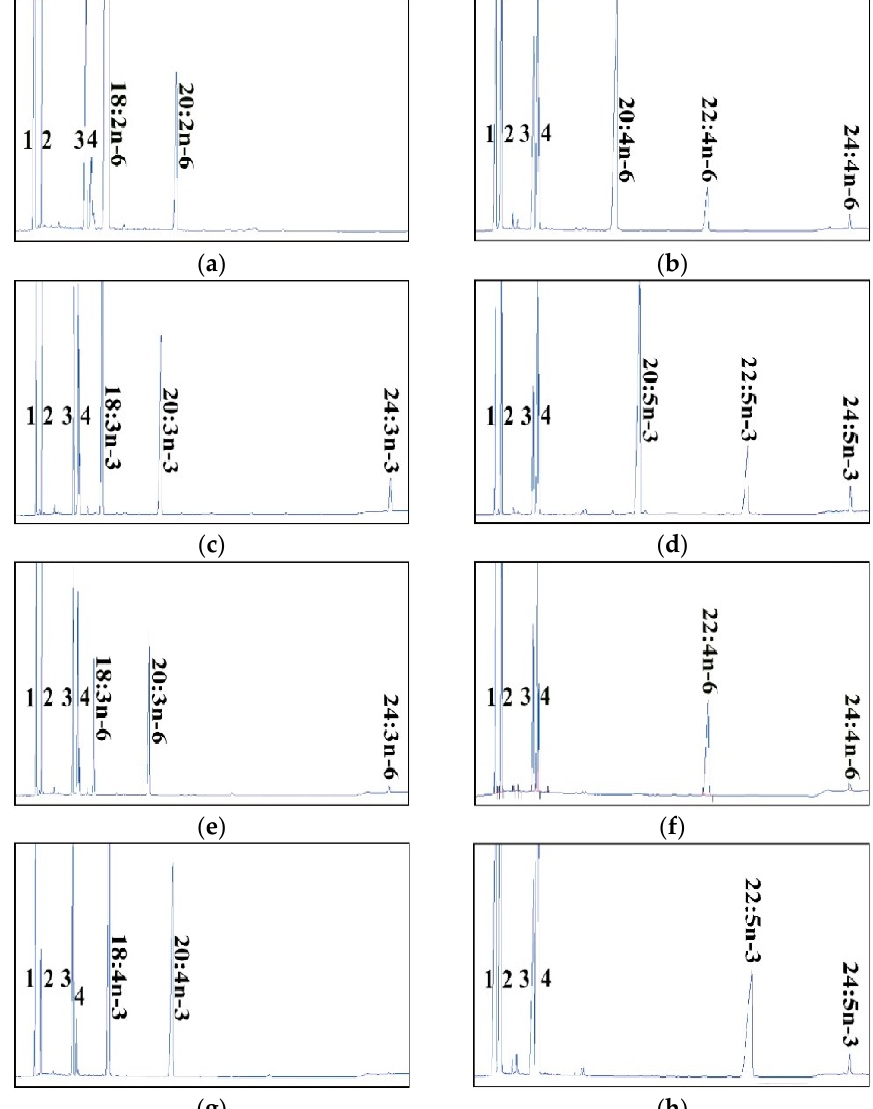
Figure 2. Elongase activities of the common carp Elovl5b in the transgenic yeasts grown in the presence of one substrate, including C18:2n-6 ( a ), C20:4n-6 ( b ), C18:3n-3 ( c ), C20:5n-3 ( d ), C18:3n-6 ( e ), C22:4n-6 ( f ), C18:4n-3 ( g ) and C22:5n-3 ( h ). The peaks from 1 to 4 represent the four main endogenous FAs of yeasts, including C16:0 (1), C16:1n-7 (2), C18:0 (3) and C18:1n-9 (4). The substrates and their corresponding elongated products are indicated. The vertical axis displays the flame-ionization detector response peak. The horizontal axis shows the peak retention time (min).